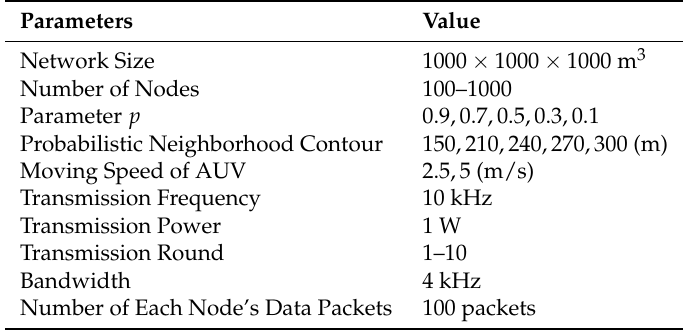
Table 1. Parameter